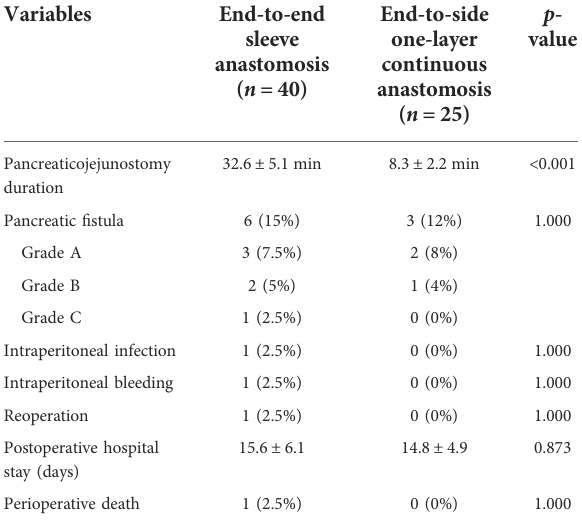
TABLE 2 Postoperative complications in two